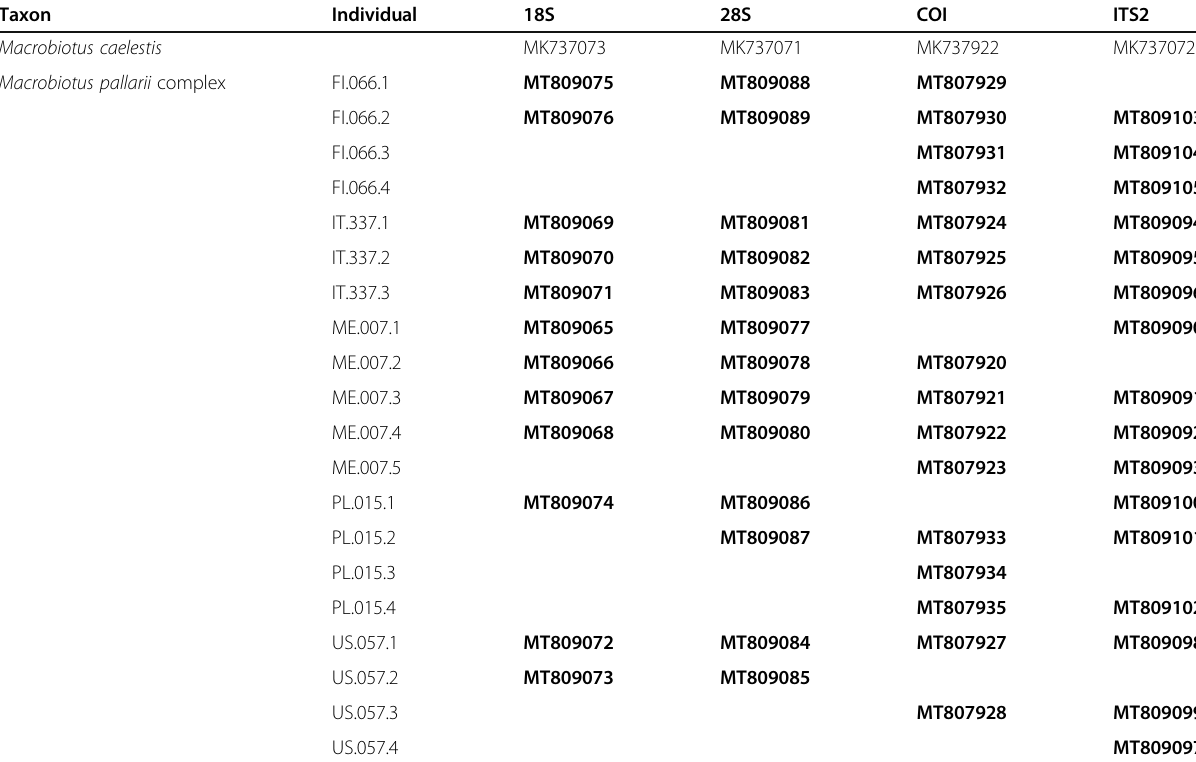
Table 3 GenBank accession numbers of sequences used in the present study. Newly generated sequences are in bold Taxon